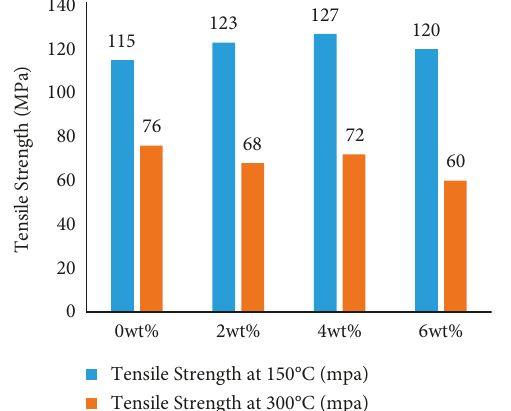
Figure 7: Effect of reinforcing particles on hardness of AA7050/ Al 2 O 3 composites.